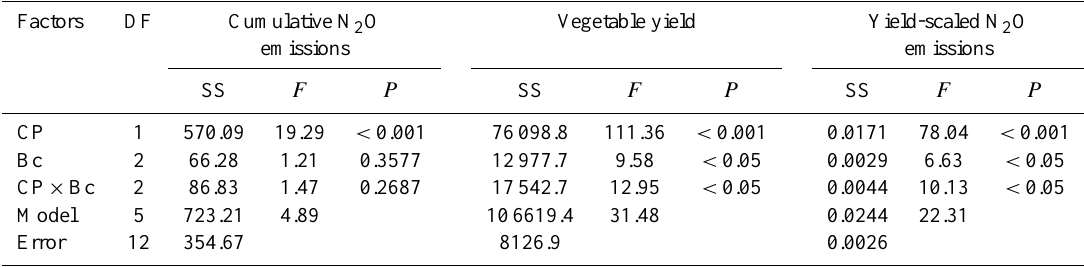
Table 4. Two-way ANOVA for the effects of nitrapyrin (CP) and biochar (Bc) on the cumulative N 2 O emissions, vegetable yield and yield- scaled N 2 O emissions over the entire experimental